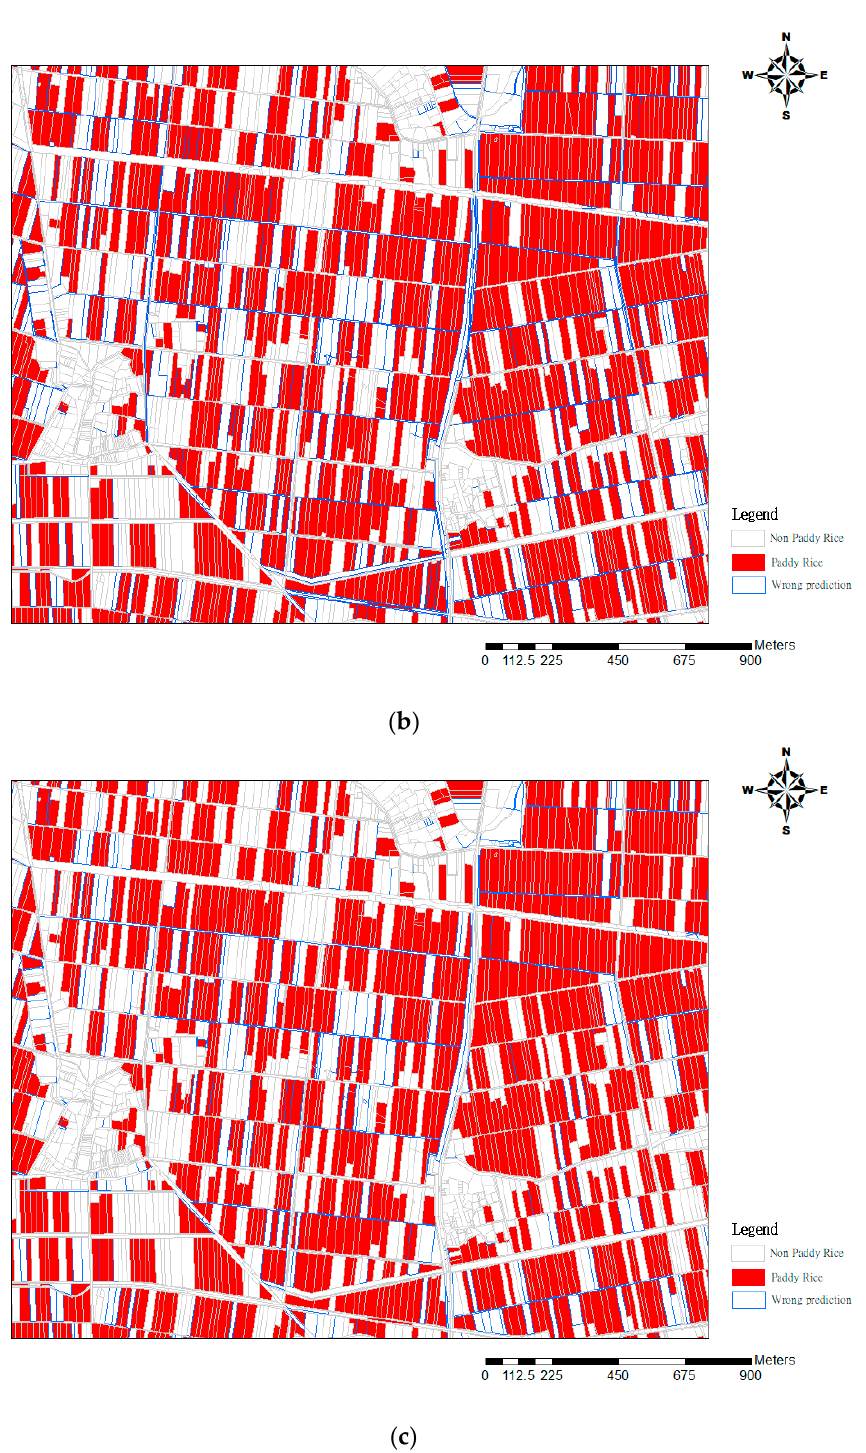
Figure 8. Comparison of direct classification and ground truth data, ( a ) SVM, ( b ) NN, and ( c ) DT.